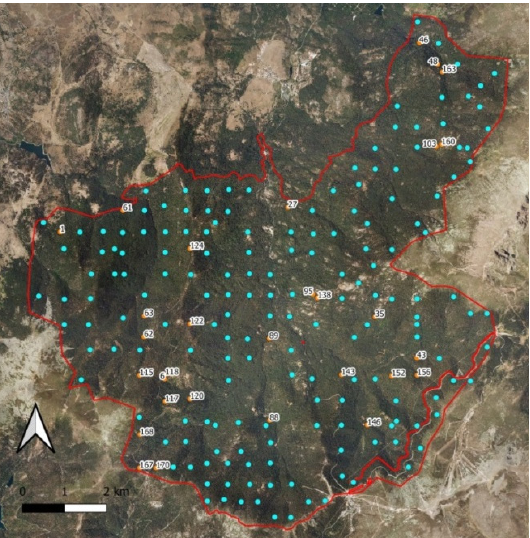
Figure 1. Plot location in the two field inventories conducted in the study area: 2009/2010 (blue) and 2016/2017 (orange, with plot identification number).